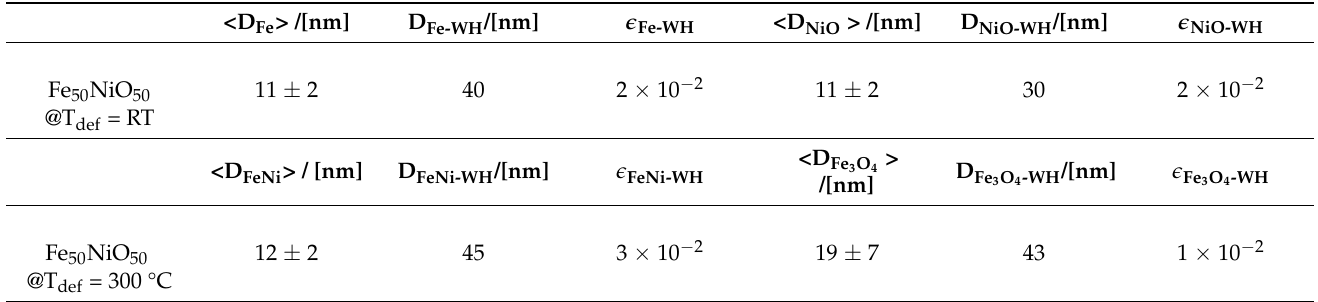
Table 1. Summary of peak analysis executed for Fe 50 NiO 50 sample deformed at RT and 300 °C. <D x > is the average crystallite size or CSDS, D x-WH represents the strain-less CSDS result and (cid:101) x-WH residual strain in the crystallite, both values are obtained via the WH